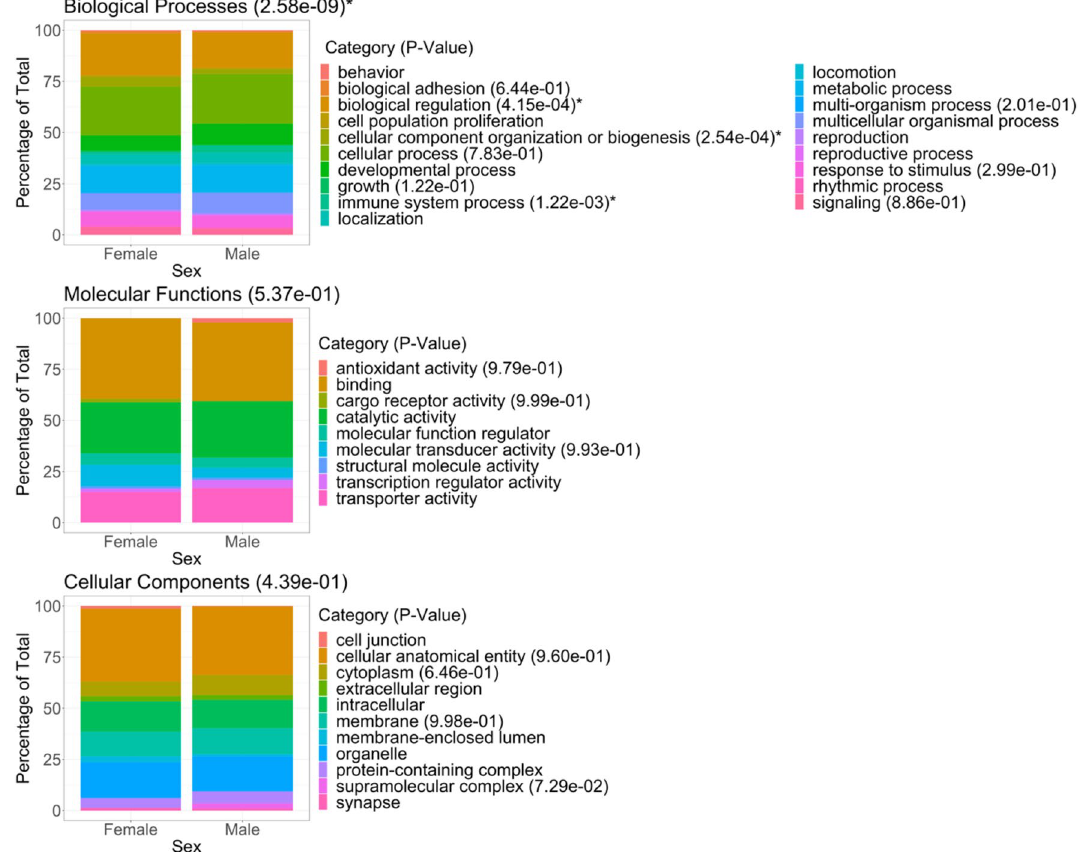
Figure 1. Gene ontology classification of seasonally differentially expressed genes for each sex. The two series of stacked bar plots correspond to all female and male seasonally differentially expressed transcripts. Sidak corrected p-values from χ 2 tests for each domain and their categories within are in brackets where those significantly different between sexes are indicated with an asterisk. Those without p-values were equal to 1 and, therefore, were not significantly different between